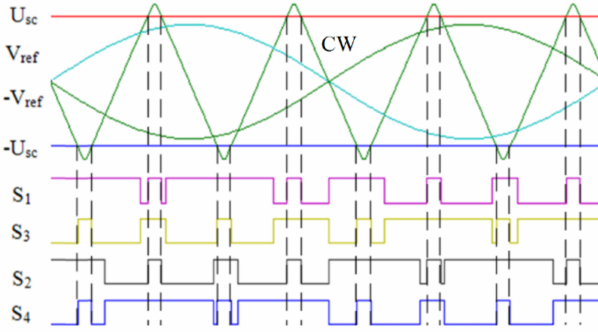
Figure 5. Simple boost switching method for the Z-source inverters (ZSI).